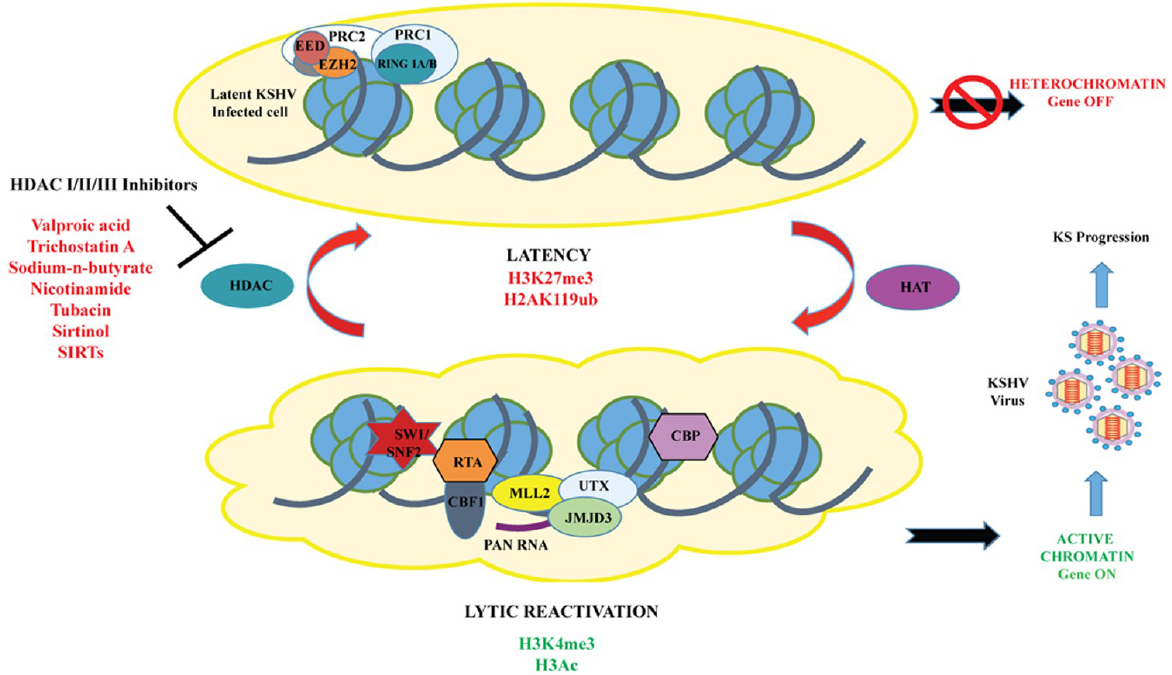
Figure 1. A model for the chromatin landscape of RTA promoter during KSHV latency and lytic reactivation. During latency, the chromatin of RTA promoter is enriched in both activating (H3ac/H3K4me3) and repressive (H3K27me3)-histone marks, as well as the